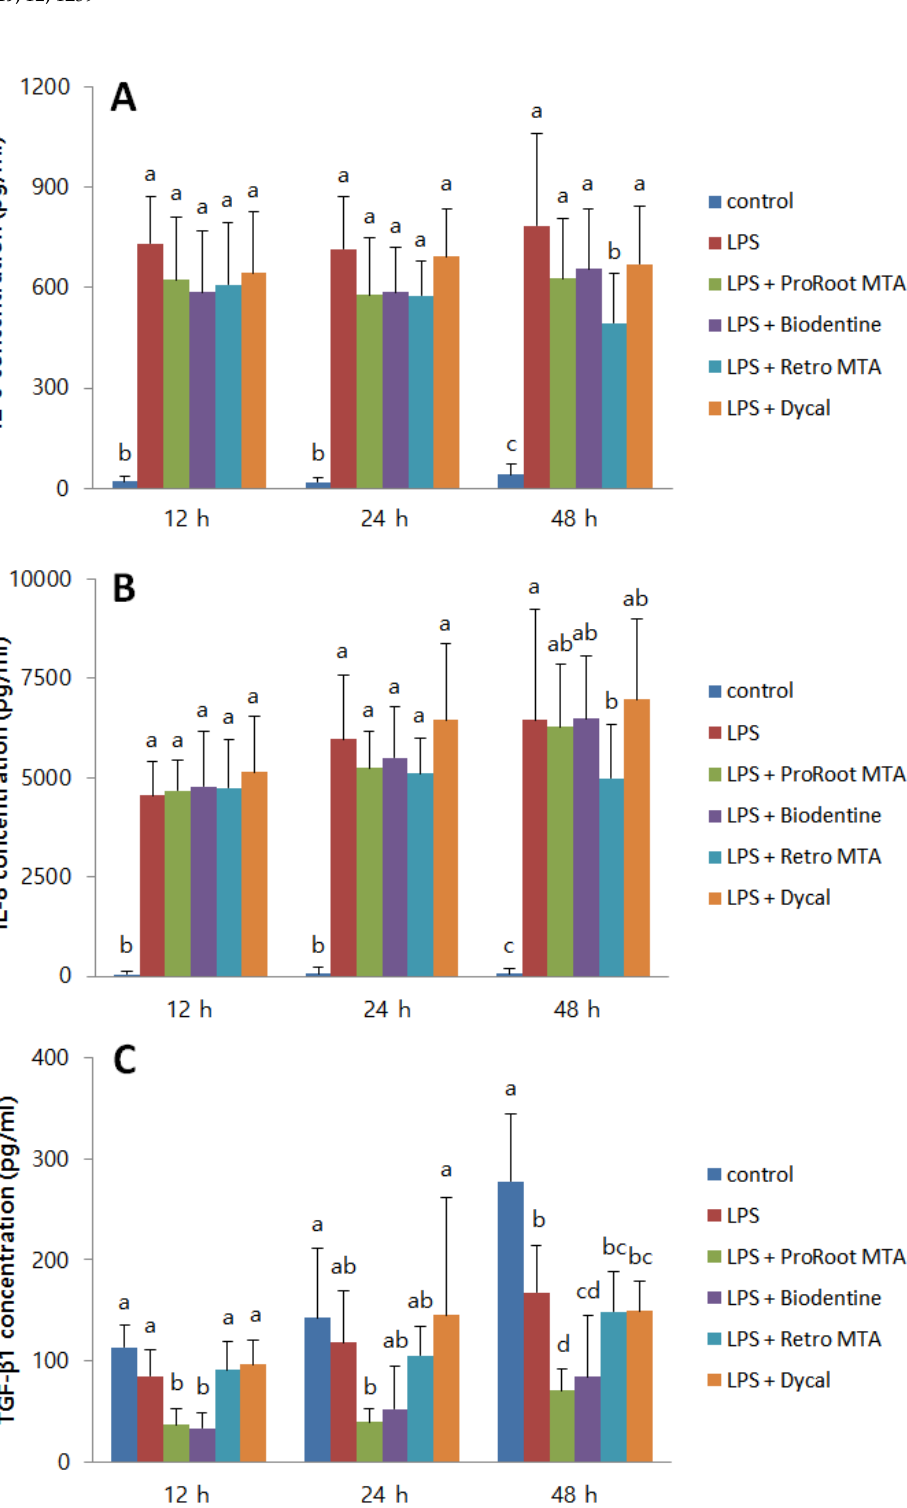
Figure 2. The effects of CSCs on the inflammatory response of LDPSCs. ( A ) IL-6, ( B ) IL-8, and ( C ) TGF-β1 expressions were measured using the enzyme-linked immunosorbent assay. ( A ) IL-6: a > b, c; b > c ( p < 0.05), ( B ) IL-8: a > b, c; b > c ( p < 0.05), ( C ) TGF-β1: a > b, c, d; b > c, d; c > d ( p < 0.05), different alphabet letters represent statistically significant differences between the materials within the same time group. Control, hDPSCs cultured with normal medium; LPS, LDPSCs cultured with normal medium; LPS + ProRoot MTA, LDPSCs cultured with ProRoot MTA extract medium; LPS + Biodentine, LDPSCs cultured with Biodentine extract medium; LPS + Retro MTA, LDPSCs cultured with Retro MTA extract medium; LPS + Dycal, LDPSCs cultured with Dycal extract